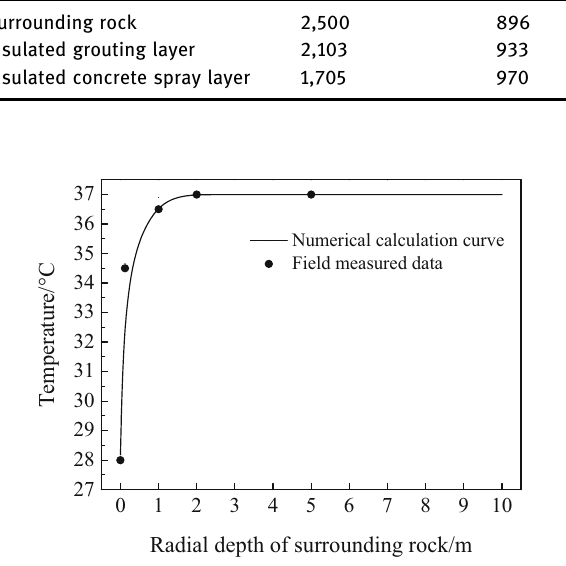
Table 2: Thermal physical parameters of the materials used in the numerical test Materials